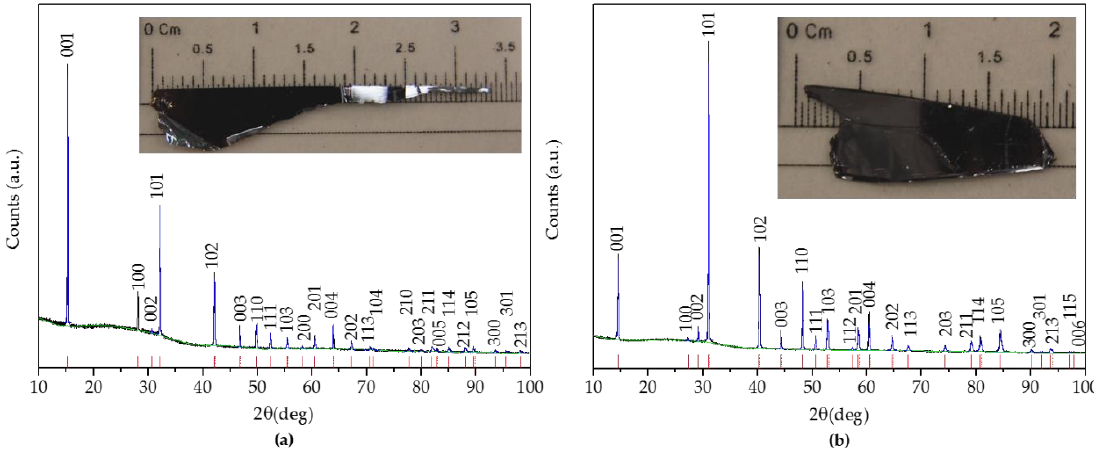
Figure A1. XRPD experimental pattern (black) and corresponding fit (peaks in blue and background in green) for ZrX 2 crystals. For simplicity, the fit has been marked with red lines. ( a ) Pattern of ZrS 2 . Inset: Photography of a ZrS 2 crystal. The fit gives as a result: a = b = 3.6628(5) Å and c = 5.8270(10) Å, trigonal crystal system with P-3m1 space group, χ 2 = 3.8 · 10 − 6 , and a Snyder´s figure of merit of 41.64. ( b ) Pattern of ZrSe 2 . Inset: Photography of a ZrSe 2 crystal. The fit gives as a result: a = b = 3.7722(4) Å and c = 6.1310(9) Å, trigonal crystal system with P-3m1 space group, χ 2 = 2.4 × 10 − 6 , and a Snyder´s figure of merit of 50.16.